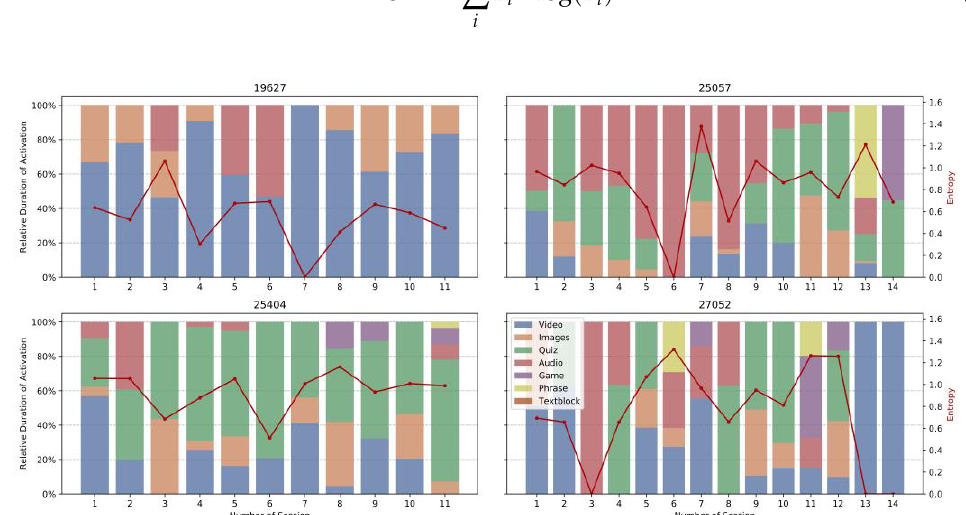
Figure 5. User Preferences over time of four individual tandems (relative duration of activations as color bars and entropy as red line).